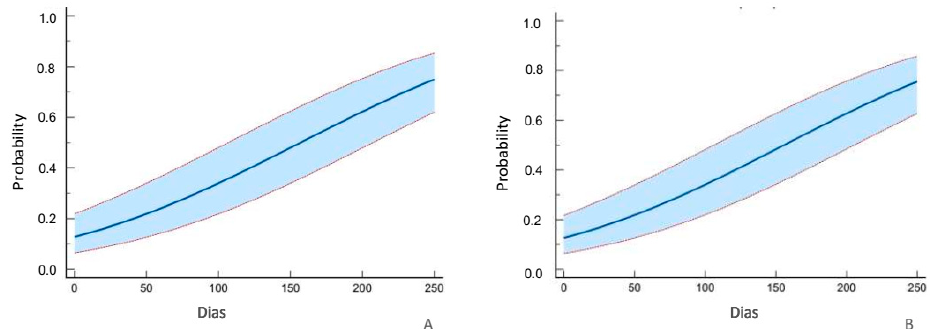
Figure 1. Probit regression of chestnut moth, Cydia splendana (Hübner), in T1 ( A ) and T2 ( B ) modali-